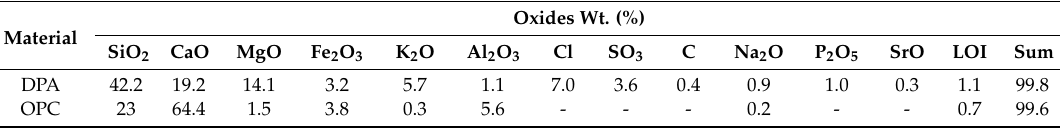
Table 1. Chemical composition of DPA and